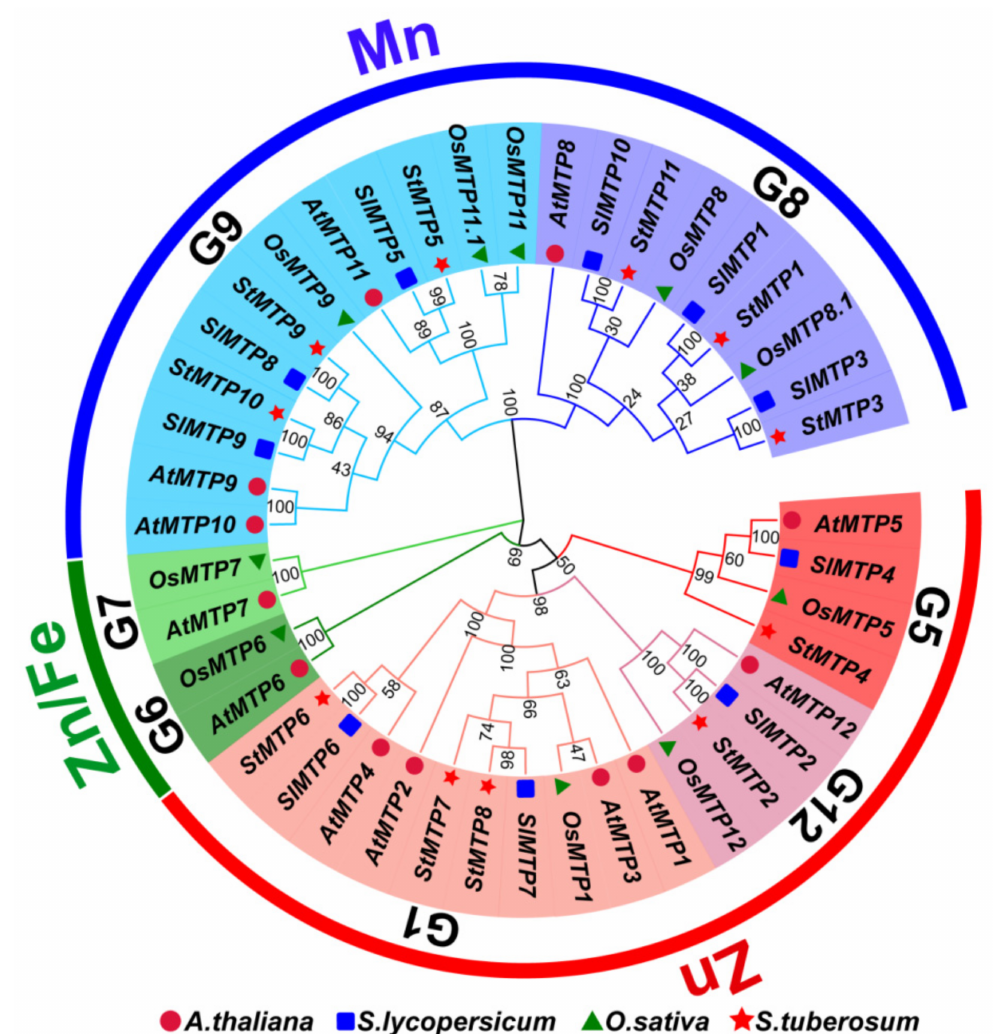
Figure 3. The Neighbor Join (N-J) method in MEGA-X (v10.1.8) software is used to construct a phylogenetic tree. Red five-pointed stars are used to indicated as potatoes, tomatoes were expressed as blue squares, red solid circles are used to represent Arabidopsis, and green triangles are used to represent